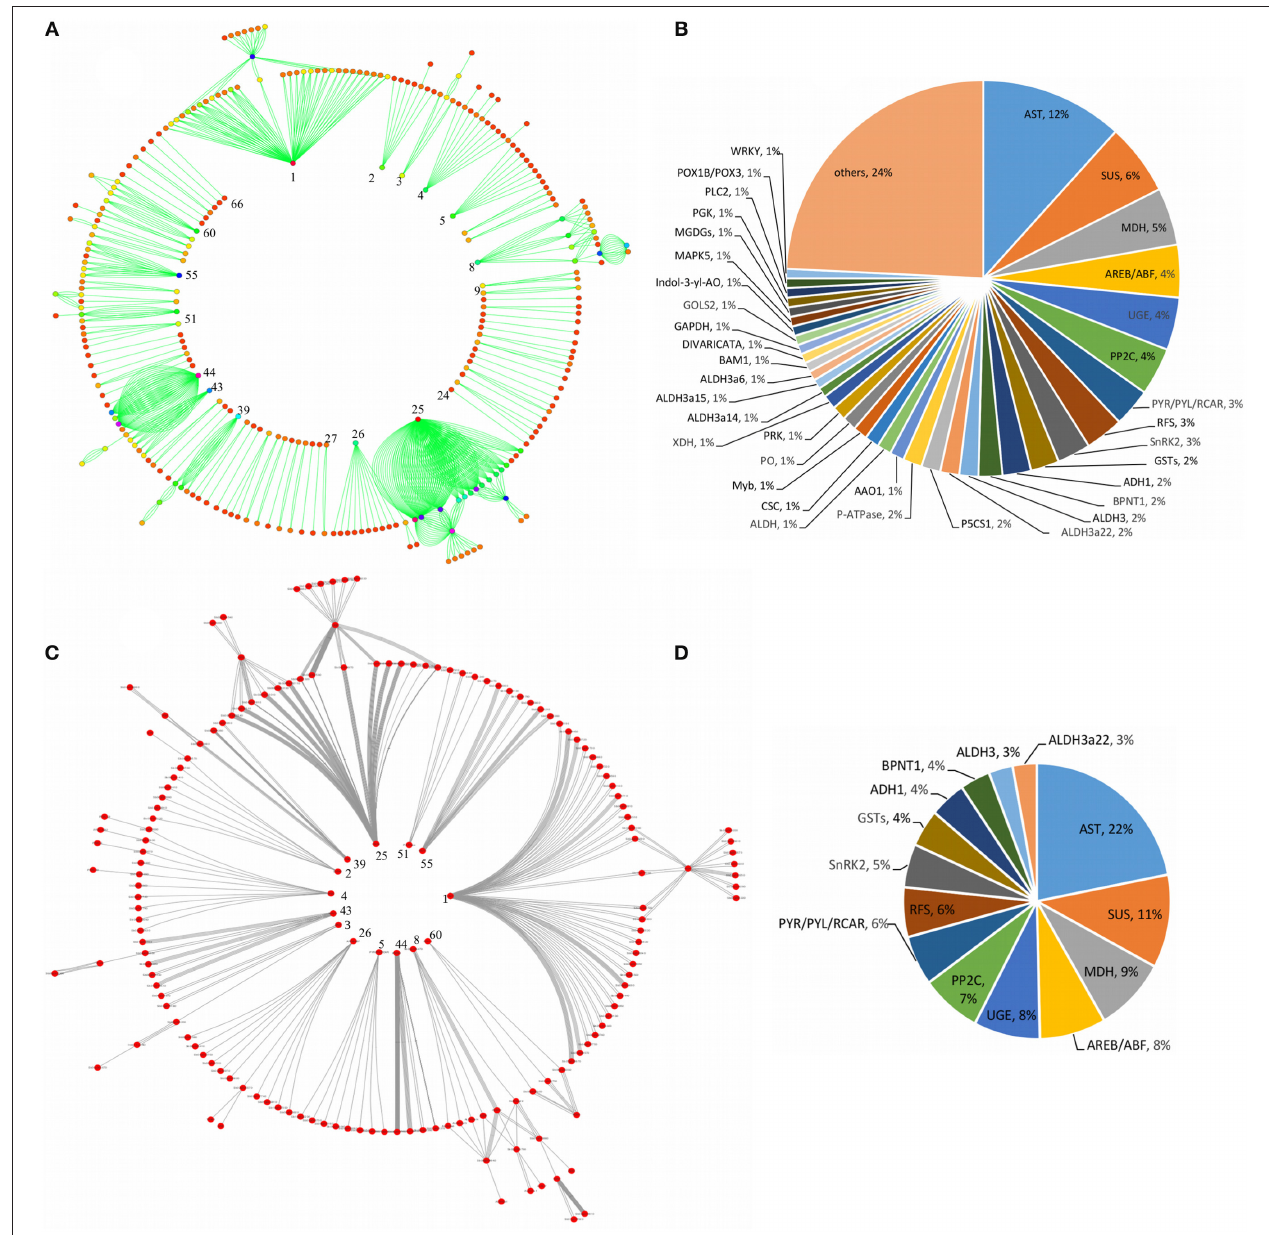
FIGURE 6 | Circular representation of the pathway cross-talk network for key genes involved in the major drought-associated signal transduction and their functional classification. The figure shows a comparative representation of an entire pathways cross-talk network in which inner labeled nodes represented by regulatory genes and the outer labeled nodes represented by target genes (A) , the classification of entire target genes into the corresponding number of regulatory genes (B) . A radial representation of a sub-pathways cross-talk network specific to drought response is shown by inner nodes represented by regulatory genes, and outer nodes represented by target genes that were extracted from the entire network (C) and the corresponding sub-group regulatory genes and the proportion of target genes classified into respective regulatory genes (D) . The numbers labeled on the node in-side the circular cross-talk network represent the nodes extracted from the entire network (A) to show the drought specific subnetwork (C)